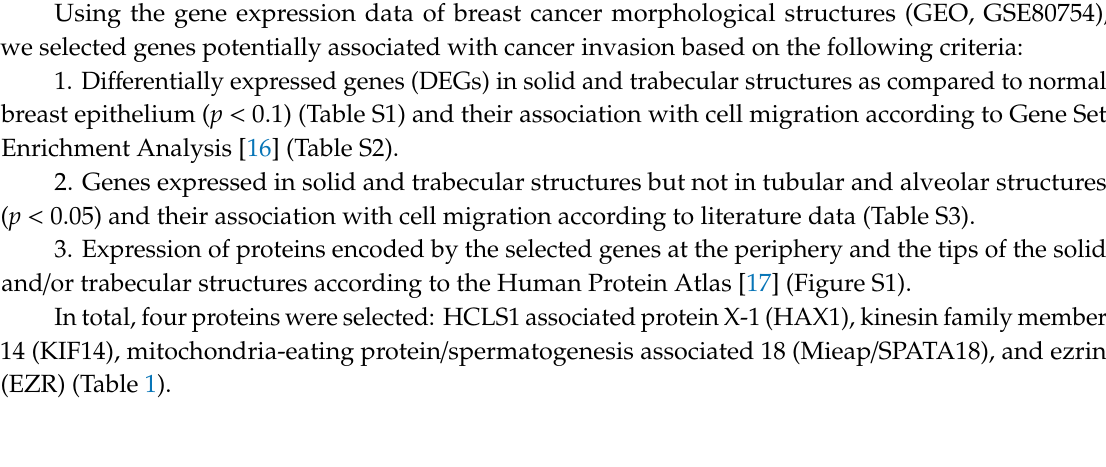
Table 1. Genes differentially expressed in solid and trabecular structures and associated with cell migration. Gene